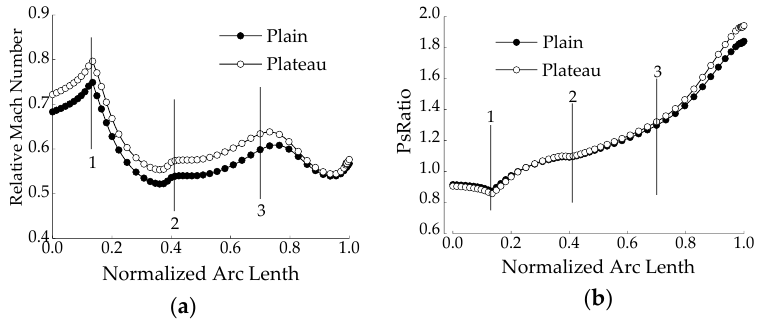
Figure 10. Distribution of relative Mach number and static pressure ratio along meridian direction: ( a ) Relative Mach number; ( b ) Static pressure ratio.